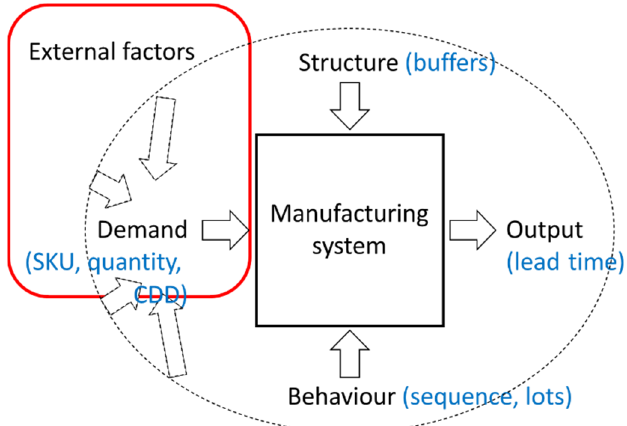
Figure 10. Experimental setup of detailed analysis.